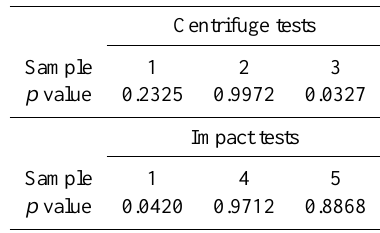
Table 3. p values from paired t test of the means for 8 ◦ configurations.